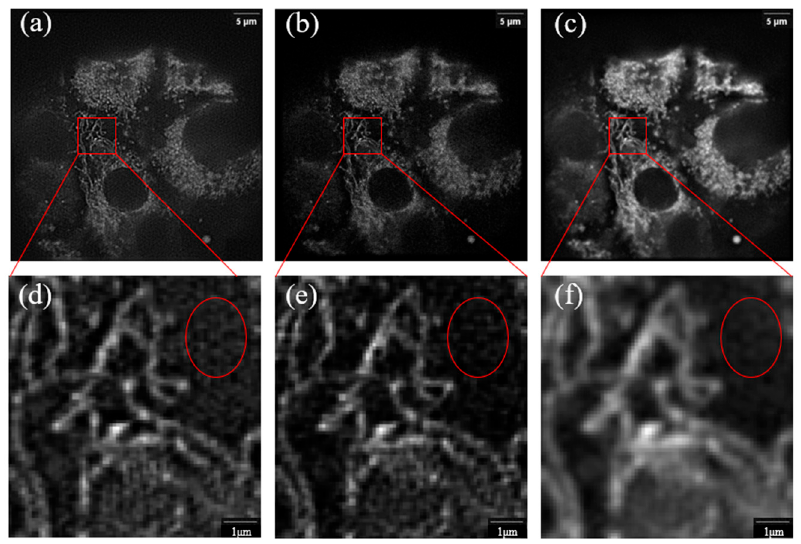
Figure 1. ( a – c ), respectively, use wiener reconstruction [33], RL reconstruction [25,26], HIFI recon- struction [31] to reconstruct the mitochondria of mouse liver cells collected under the 60 × objective lens; ( d – f ) are magnified images of square areas in ( a – c